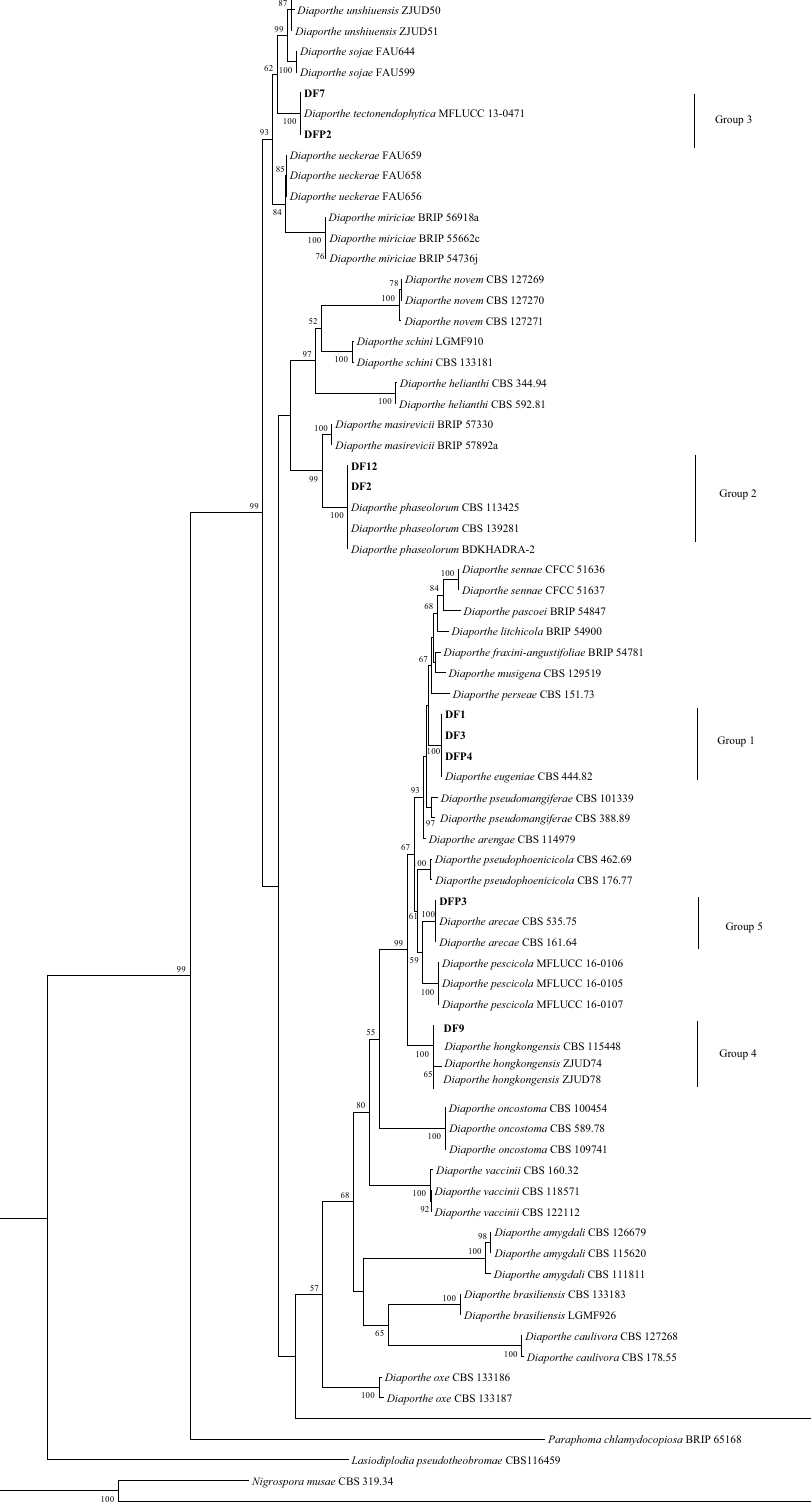
Figure 2. Maximum-likelihood tree of Diaporthe species isolated from stem gray blight of H. polyrhizus based on combined dataset of ITS, TEF1-α, and β-tubulin using Tamura and Nei model with 1000 bootstrap replications. Isolates of the present study are presented in bold and other fungal genera are used as an outgroup . Bootstrap values are shown at the nodes and the scale bar indicates the number of substitutions per